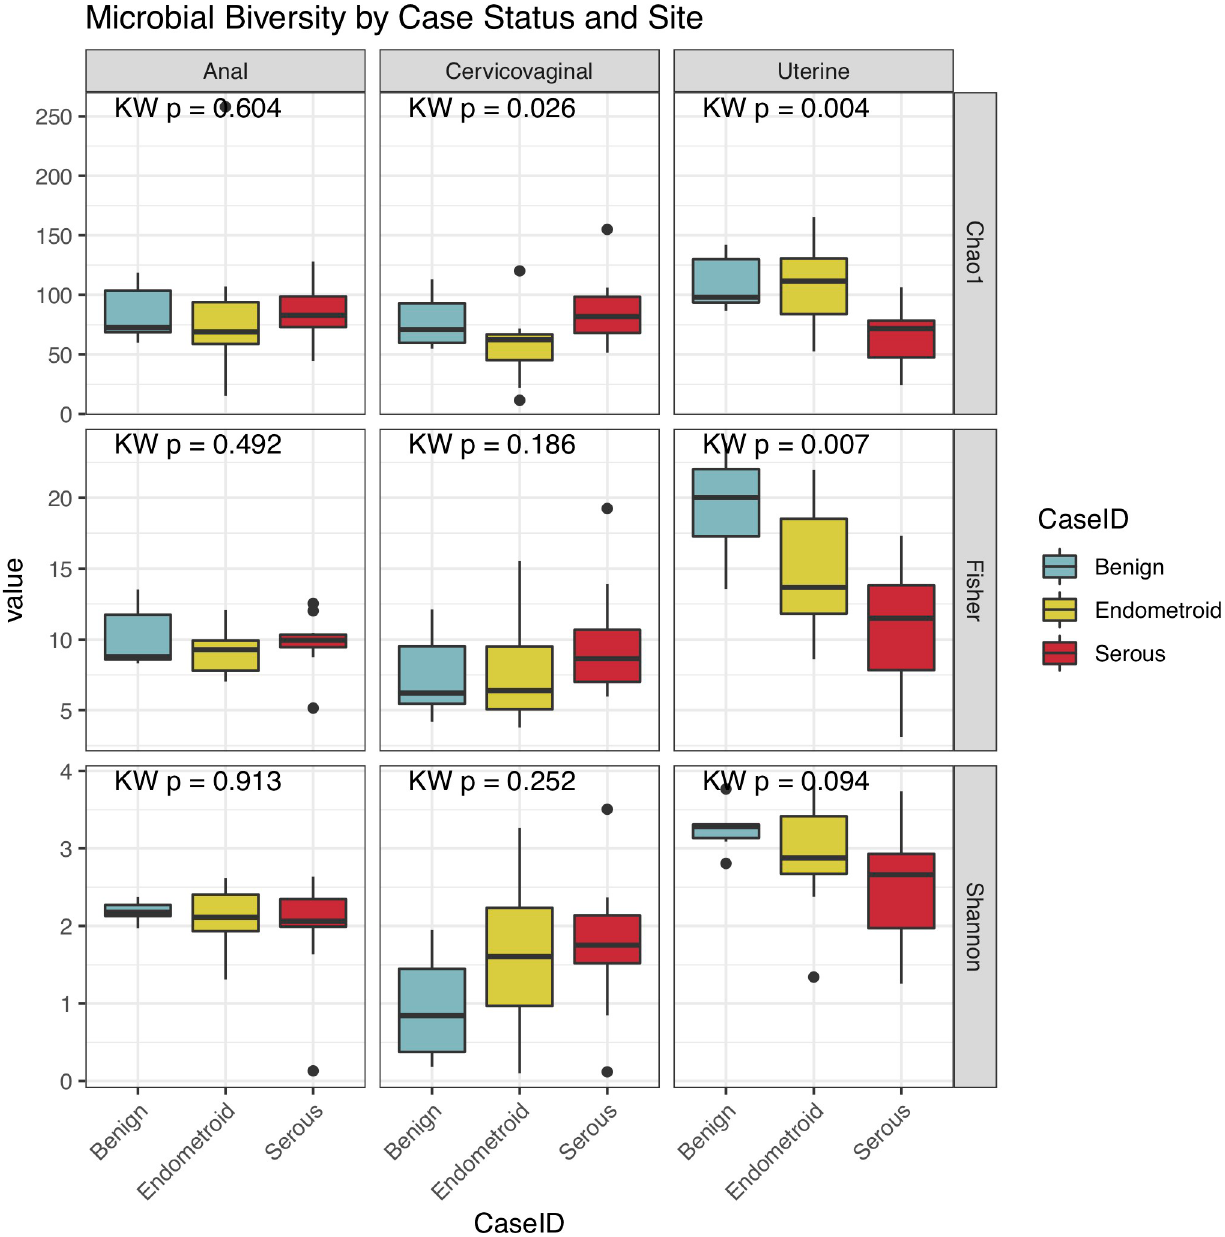
Fig 3. Microbial alpha diversity analysis of anorectal, cervicovaginal and uterine samples. The plot indicates that serous cancer is characterized by a significant reduction of the uterine microbiome diversity based on the Chao1 (p = 0.004) and Fisher (p = 0.007) measures with a marginally significant reduction in Shannon Diversity (p = 0.094). The Kruskal-Wallis (KW) statistic is shown at the top of each plot.